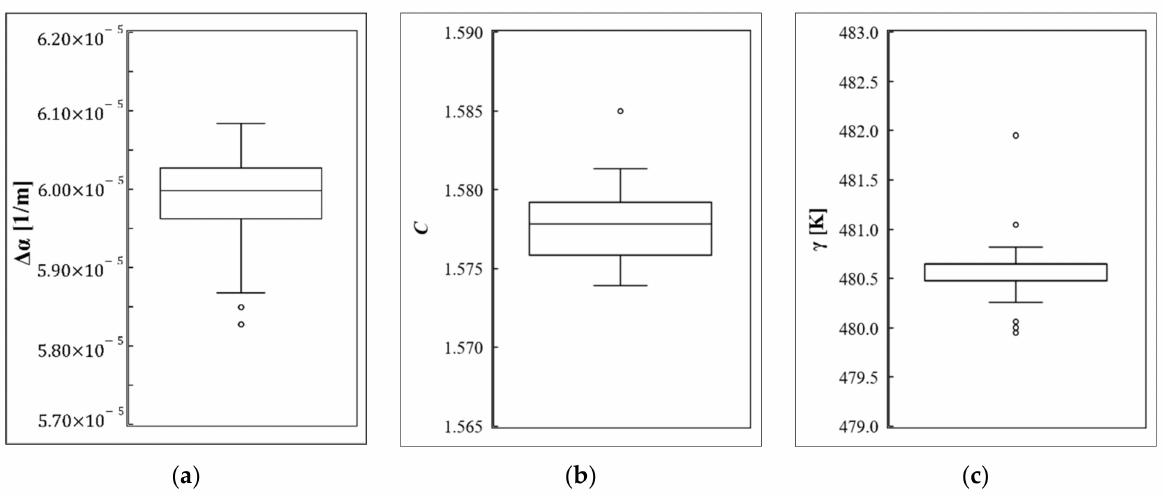
Figure 10. Estimated values of calibration parameters. ( a ) ∆ α : differential attenuation parameter, ( b ) C: laser and DTS instrumentation parameter, and ( c ) γ : energy shift-related parameter.